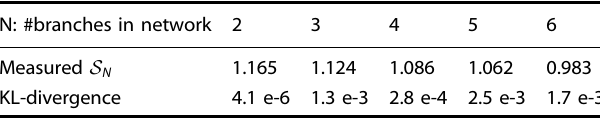
Table 2. Results for N -branch star network nonlocality experiments on the ibmq_almaden quantum